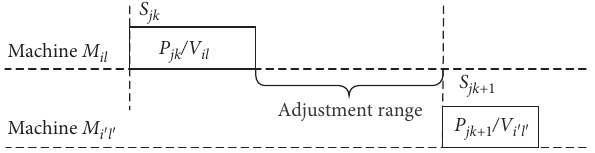
Figure 8: Adjustment diagram when S